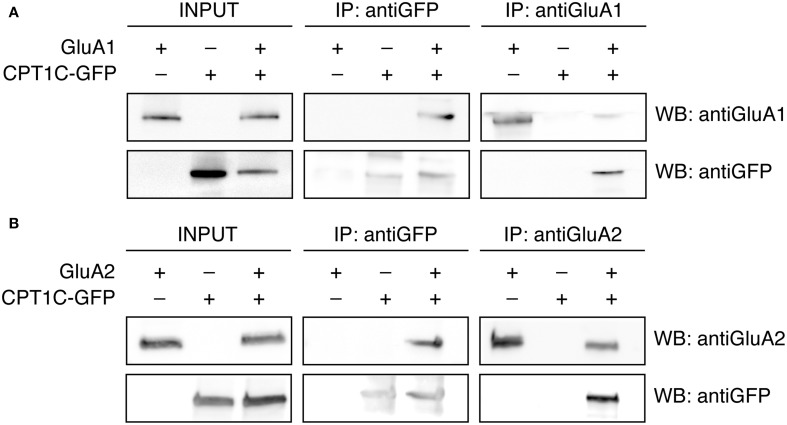
GluA1 and GluA2 coimmunoprecipitate with CPT1C in expression systems. (A) Co-IP of the membranous fraction of tsA201 cells co-expressing either GluA1 alone or together with CPT1C-GFP confirming the interaction between CPT1C and GluA1. As a negative control GluA1 was co-expressed with an empty plasmid expressing GFP alone (pEGFP) and CPT1C-GFP was co-expressed with an empty plasmid (pcDNA3.0). Transfected cells were lysed and membranes were solubilized. 200-400 μg of solubilized membranes was immunoprecipitated with an anti-GFP antibody (IP: antiGFP) or with anti-GluA1-NT antibody (IP: antiGluA1). An input sample collected prior to immunoprecipitation of these extracts is shown as “INPUT.” Inputs and immunoprecipitated samples were separated using SDS-PAGE and Western Blot was performed using anti-GluA1-NT (WB: antiGluA1) or anti-GFP (WB: antiGFP) antibodies. Immunoprecipitations were performed three times. (B) Same as in (A) but for tsA201 cells expressing GluA2 or GluA2 plus CPT1C-GFP. Membrane lysates were immunoprecipitated with an anti-GFP antibody (IP: antiGFP) or a rabbit polyclonal anti-GluA2 (cytoplasmic domain) (IP: antiGluA2). Western Blots were performed using mouse anti-GluA2 (WB: antiGluA2) or anti-GFP (WB: antiGFP) antibodies. Immunoprecipitations were replicated three times.